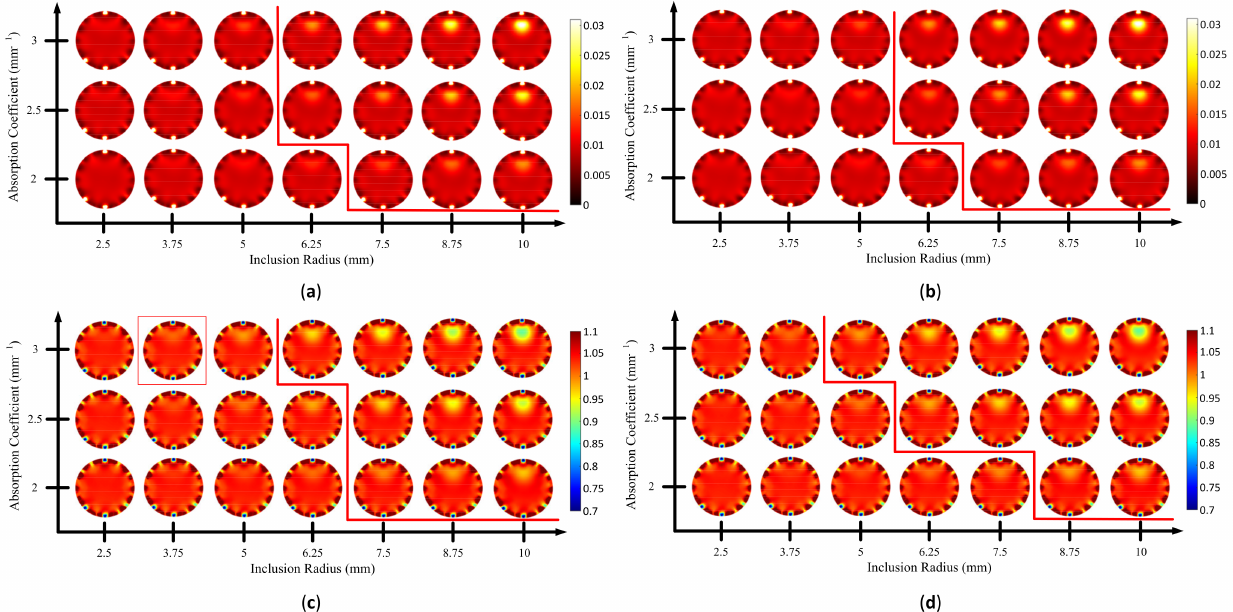
Figure 18. Reconstructed images of case B1 with 10% noise amplitude, phase, and optical properties; red line indicates the invisible ( left side ) and visible ( right side ) inclusions: ( a ) µ a MS-ISSIM-S, ( b ) µ a MOS, ( c ) µ (cid:48) s MS-ISSIM-S, and ( d ) µ (cid:48) s MOS.